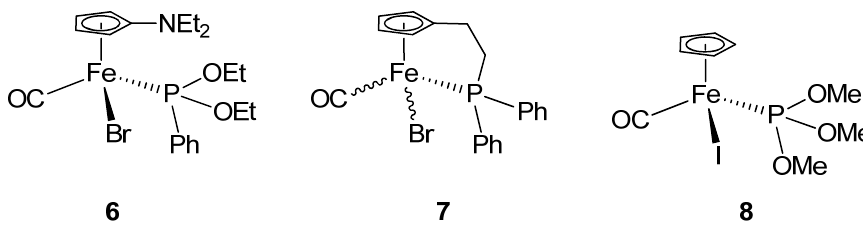
Figure 4. Structurally related pianostool type iron